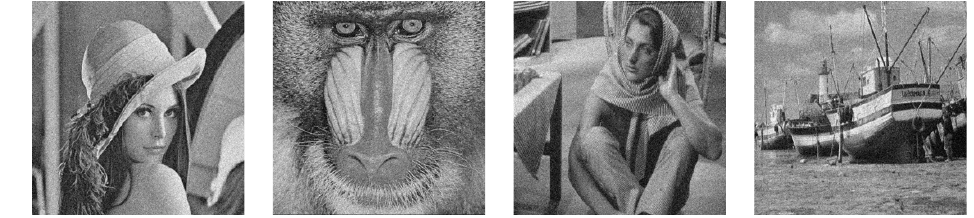
Figure 5. C orresponding noisy images corrupted by AWGN ( σ = 30) .